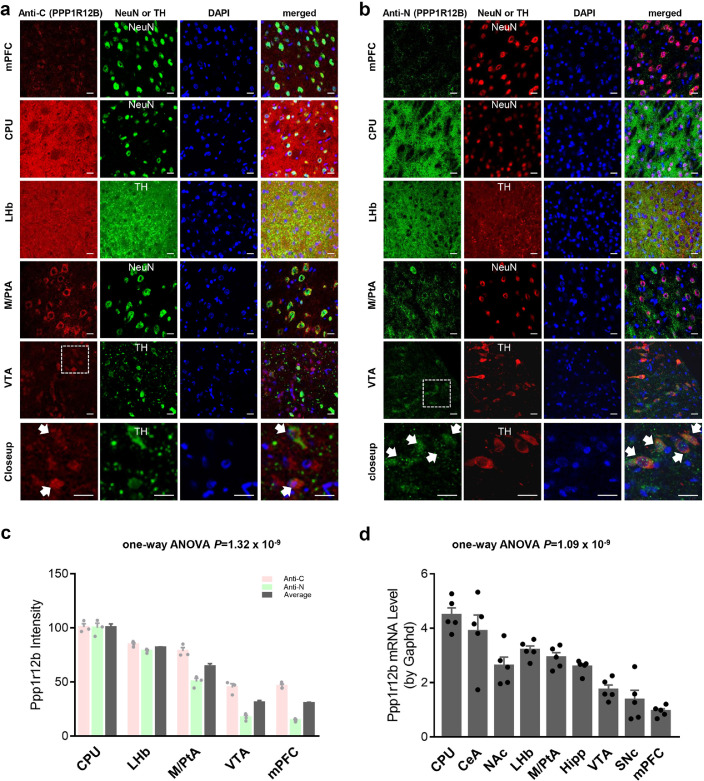
Ppp1r12b expression in different brain regions. (a-b) Immunoreactivities in five representative rat brain regions (mPFC, CPU, LHb, M/PtA and VTA) are shown here. Left column, PPP1R12B antibody (Anti-C, in red) recognized C-terminus in a; PPP1R12B antibody (Anti-N, in green) recognized N-terminus in b; second and third columns, anti-NeuN or anti-TH (green or red), and DAPI (blue); right column shows the merged staining. Clear neuronal staining was observed in VTA, mPFC and M/PtA; diffuse staining was observed in the LHb and CPU, consistently. In the bottom rows as a closeup of VTA, arrows indicate co-localization of Ppp1r12b and TH in dopamine neurons. Scale bars, 50 µm (other regions examined but not shown here: SNc was similar to VTA with a distinct cellular pattern; CeA and NAc were similar to diffuse CPU; hippocampus had a pattern in between mPFC and LHb). (c) Densitometry analysis of Ppp1r12b immunoreactivities observed in a (in light red) and b (in light green), and the average (in dark grey) of immunoreactivities, showing regional expression which was verified by one-way ANOVA results (n = 3). Information for additional regions was collected but less consistent so not shown. (d) Mouse brain regional expression by mRNA levels. Differential expression was verified by one-way ANOVA analysis. VTA and mPFC had no significant difference by Tukey's multiple comparisons (P = 0.29) (n = 5/group).